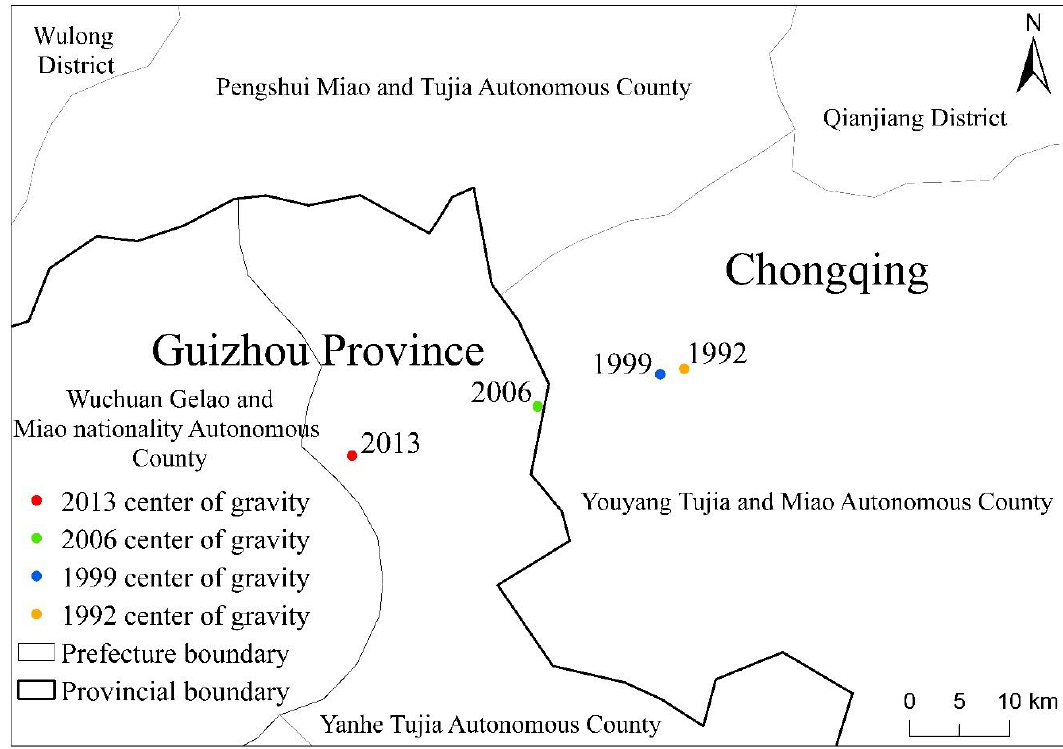
Figure 6. The center of gravity of urban land expansion in the YREB over four years.